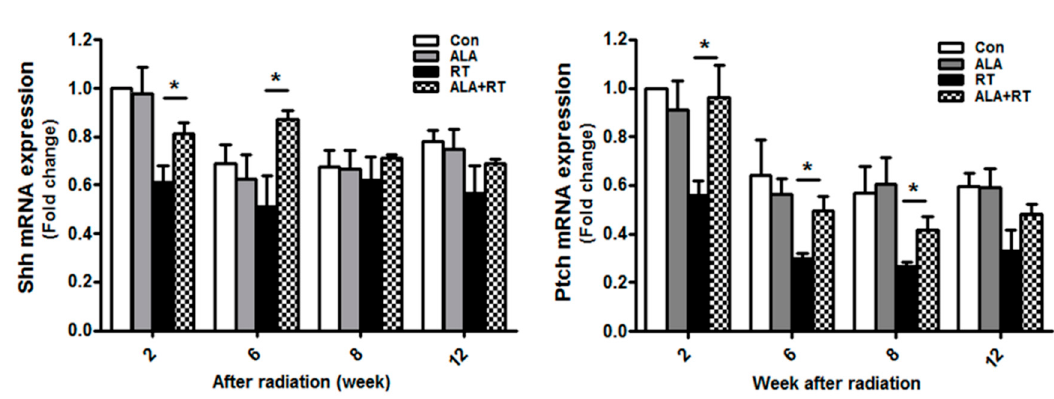
Figure 5. ALA rescues Hh signaling in SGs after irradiation. Sprague–Dawley rats were subjected to 18 Gy radiation in the head and neck region. SGs were collected at each time points, and RNA was extracted and subjected to qPCR analysis of Shh and Ptch expression. N = 12–16 SGs / group. Values are represented as the mean ± SEM. * p < 0.05.